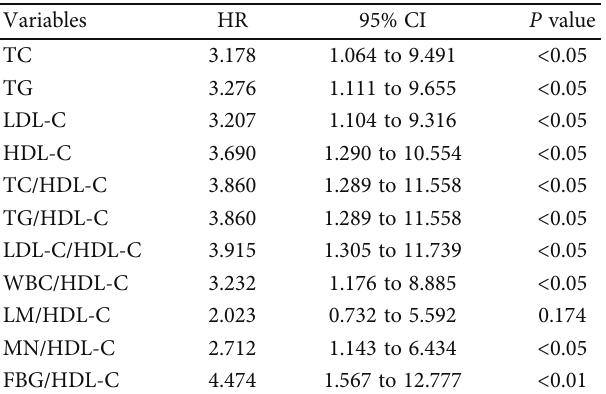
e ff ects of di ff erent variants of the results, and (5) sample size limitation.